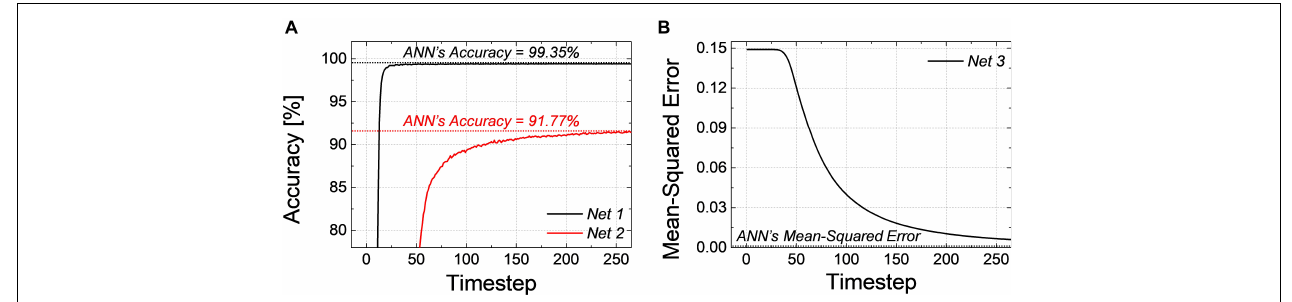
FIGURE 1 | (A) Accuracy of Net 1 , 2 and (B) MSE of Net 3 according to the simulation timestep. Time to reach ANN’s performance is required because of the latency of SNN.